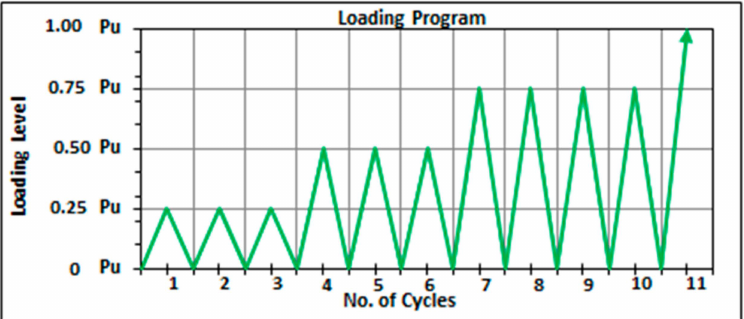
Figure 5. Loading program of the cyclic loaded specimens.